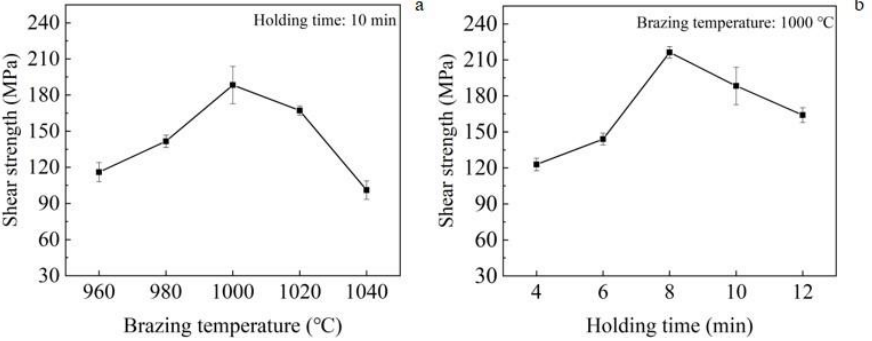
Figure 9. Shear strength of Ti 2 AlNb/GH99 joints at various parameters. ( a ) Brazing temperature and ( b ) holding time. ( b ) holding time.